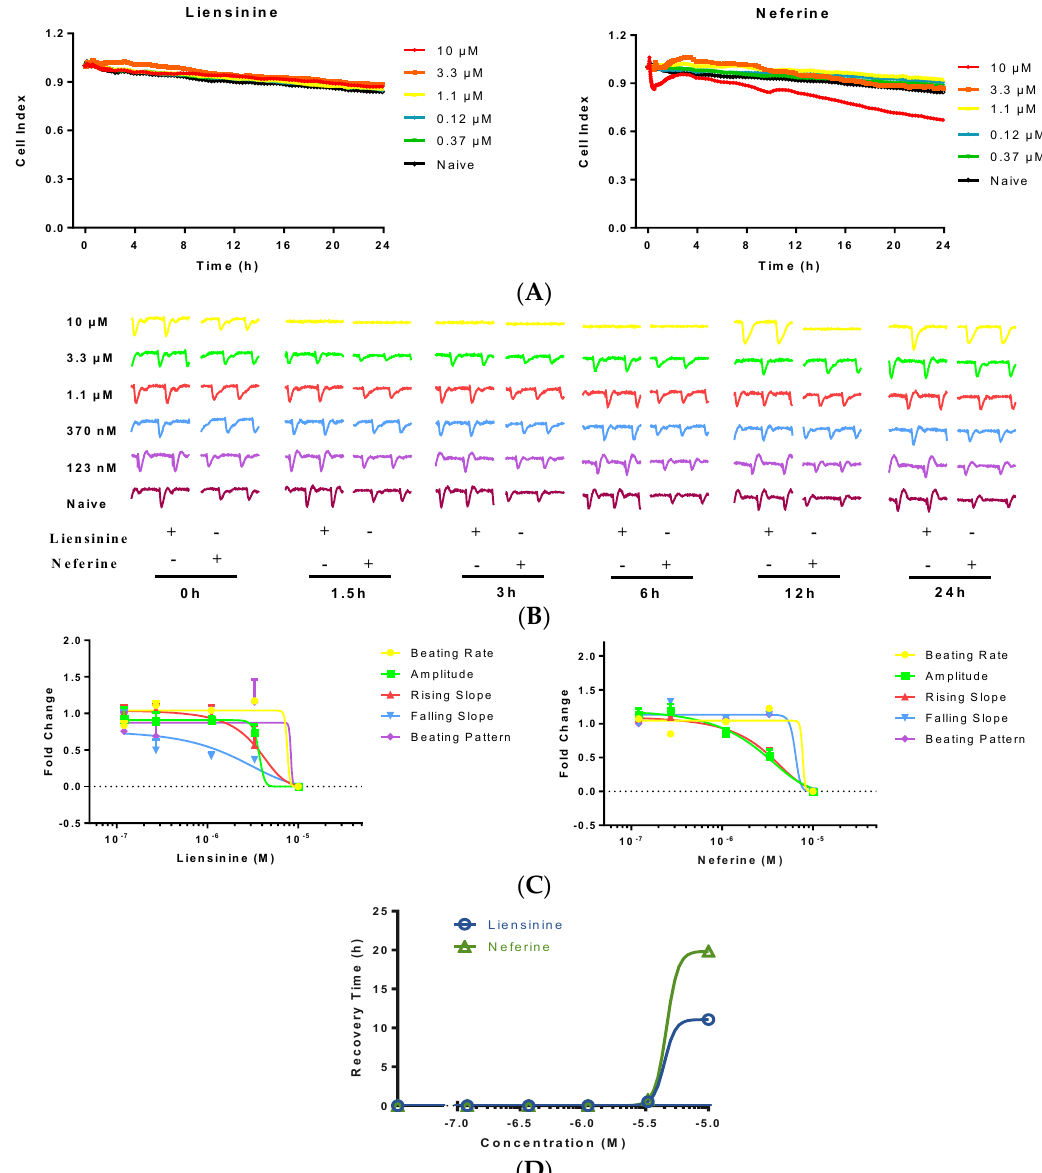
Figure 4. Typical contraction profiles and dose responses of rat neonatal and hiPS-CM to liensinine and neferine treatment. ( A ) Cell index fluctuation after various doses of liensinine treatment; ( B ) Temporal profiling of hiPS-CM beating functions treated by various doses of liensinine or neferine; ( C ) Dose response to liensinine and neferine of hiPS-CM 3 h after compounds treatment. Five hiPS-CM beating parameters, including beating rate, amplitude, raising slop, falling slop and beating pattern, were used for evaluation; ( D ) Recovery time of beating rate of hiPS-CM treated with various concentrations of tested compounds. Data were presented as mean ± SD, n = 3.